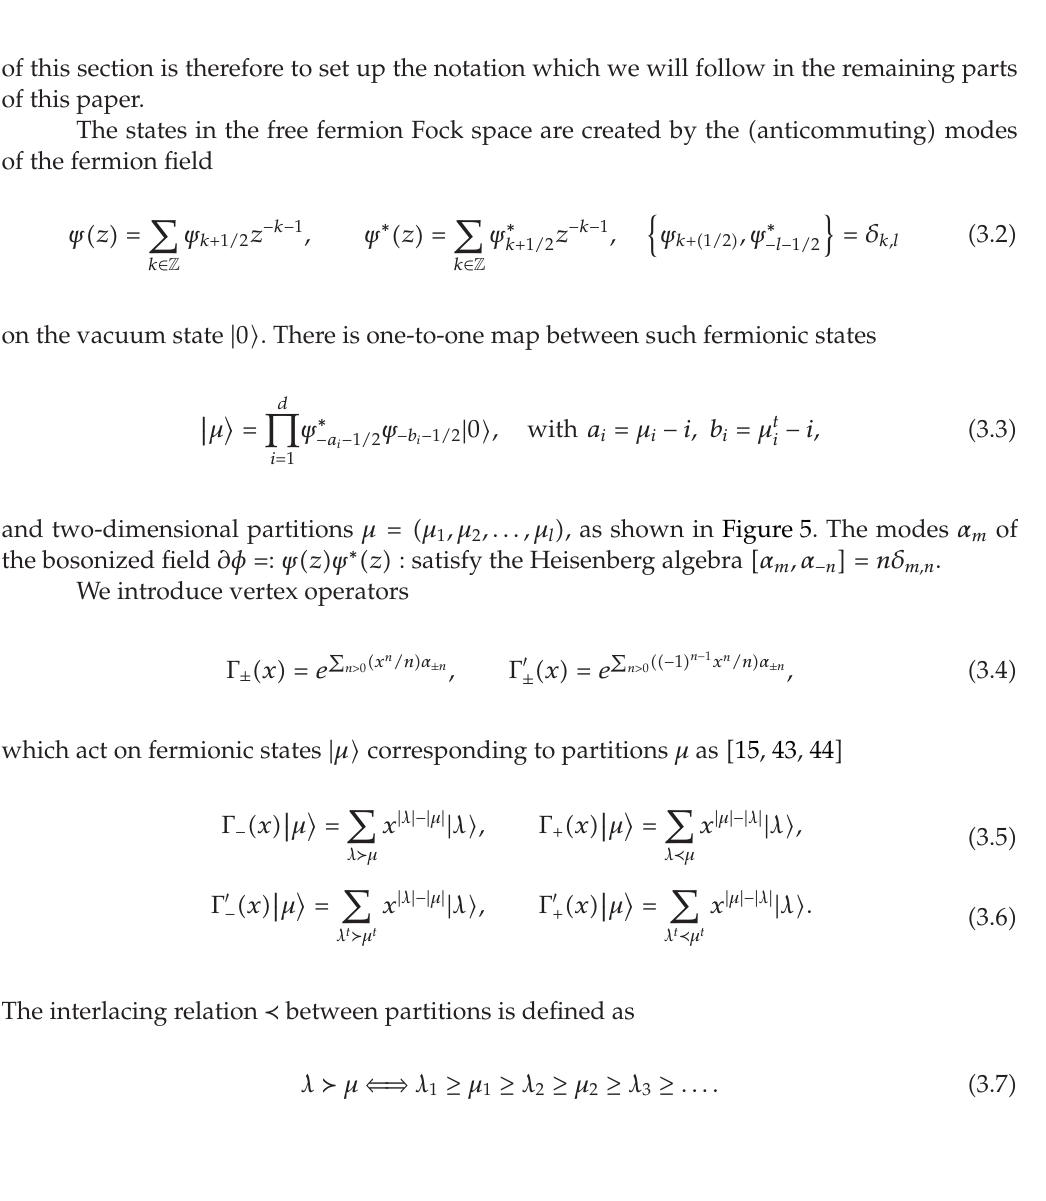
Figure 5: Relation between Young diagrams and states in the Fermi